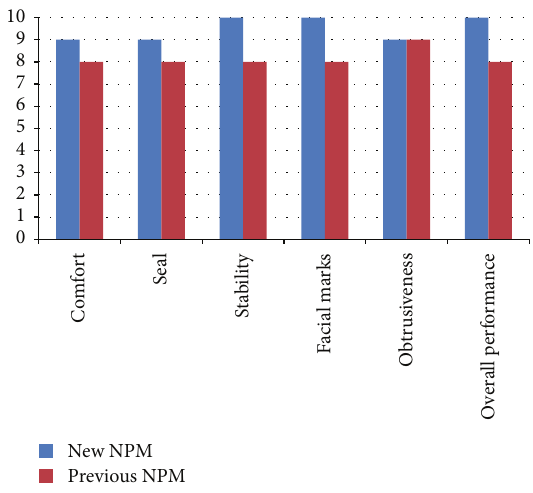
Figure 1: Average scores of participants asked to rate the new NPM compared with their current NPM (Group 2). Participants were asked to rate each aspect of the mask using an 11-point Likert Scale where 0 means poor performance and 10 means excellent performance.